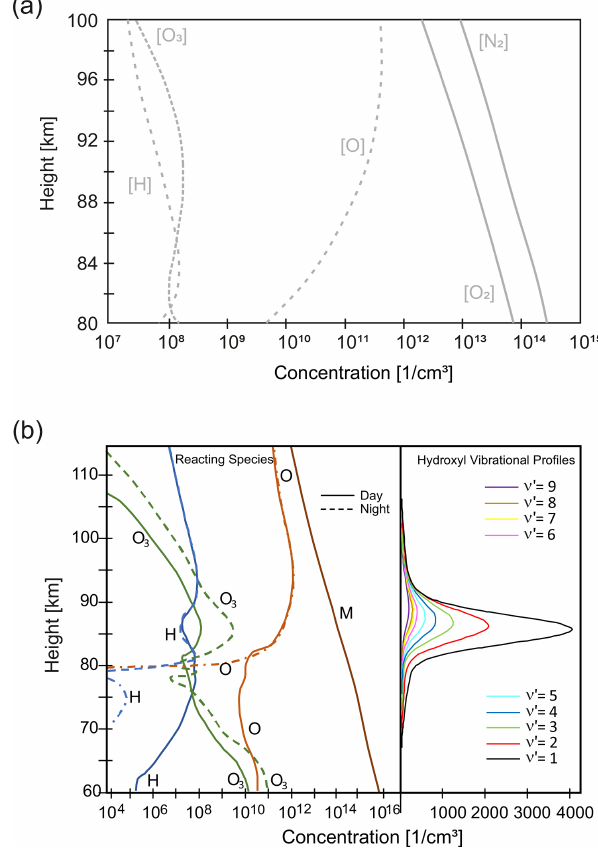
Figure 1. (a) Number density of the two major (O 2 and N 2 , solid lines) and the three minor (O 3 , O, and H, dashed lines) species in- volved in the production of OH ∗ between 80 and 100km height following Swenson and Gardner (1998) according to MSIS-90. Rel- atively large uncertainties exist for the number density of atomic oxygen (Richter et al., 2021), which also shows seasonal variations (e.g. see Fig. 2.15 in Khomich et al., 2008). (b) Left panel: verti- cal profiles of the major-reacting species in the OH photochemical scheme for daytime (solid) and nighttime (dashed) conditions be- tween 60 and 115km height, M denotes a collisional partner (re- produced from Battaner and Lopez-Moreno, 1979). Right panel: modelled OH ∗ profiles for v (cid:48) = 1–9 (adapted from Xu et al., 2012).